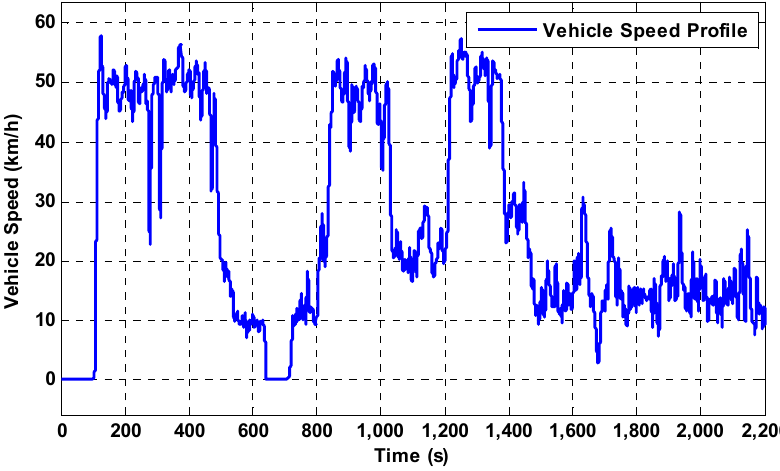
Figure 12. The internal developed driving cycle related to military tactics.